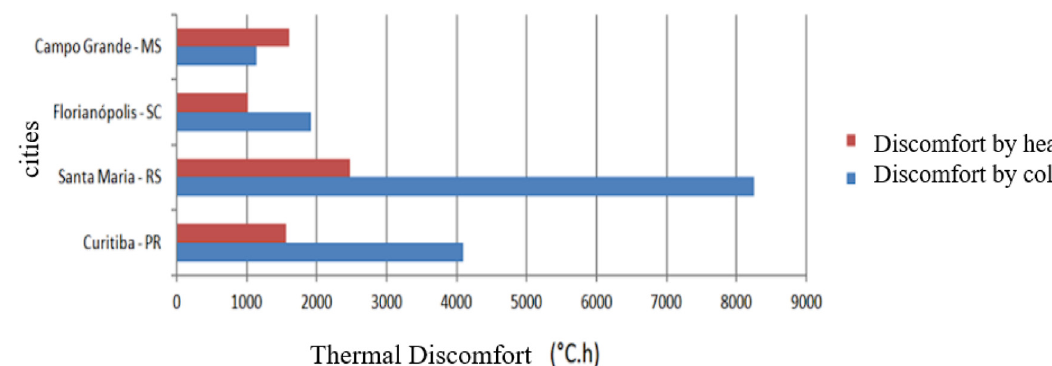
Fig. 6. Total discomfort in ° C h due to cold and heat for cities in Campo Grande, Florianópolis, Santa Maria and Curitiba.